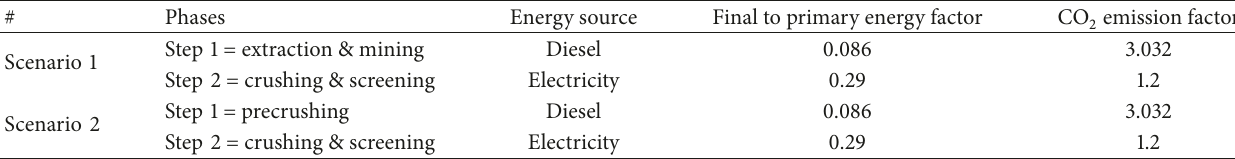
Table 1: Scenarios, phases, and used conversion factors of the study.